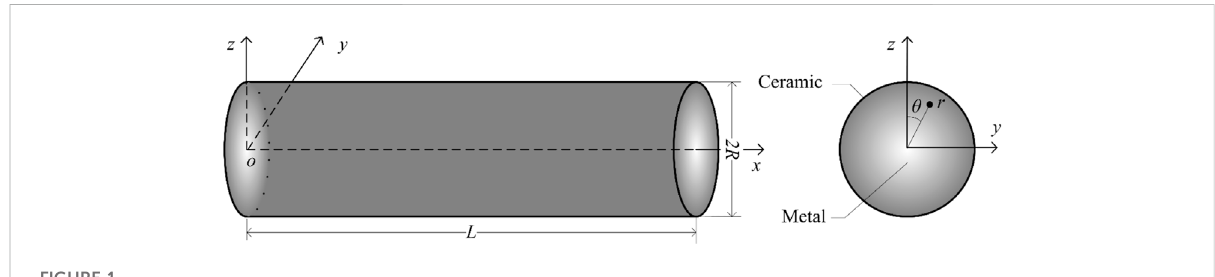
FIGURE 1 A straight radial FG beam with uniform circular